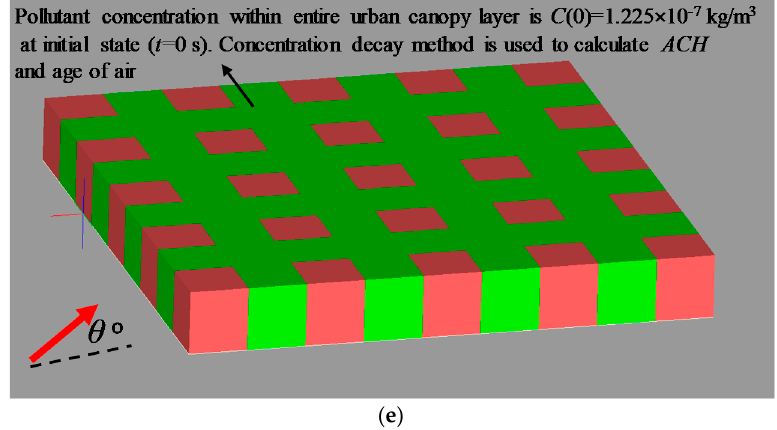
Figure 2. ( a ) Model description and ( b ) computational domain of Case [5-5, 0°] ( θ = 0°); ( c ) Computational domain in Case [5-5, θ ] ( θ =15°, 30°, 45°); ( d ) Model description of Case [5-5, θ ,